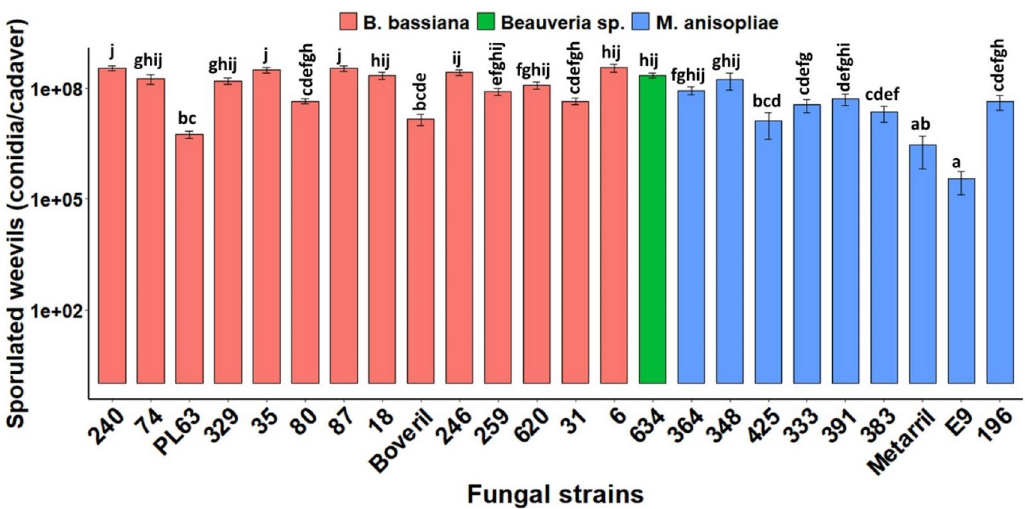
Figure 3. Secondary inoculum production by infected weevils’ cadavers of various strains of M. anisopliae and B. bassiana after incubation in saturated humid chambers. Data were fitted to a generalized linear model with negative binomial distribution, and estimated means (± SE, n = 10 replicates) were statistically separated by Tukey HSD test at P < 0.05. Note that B. bassiana IBCB-66 was not included in this analysis, as it had one weevil that